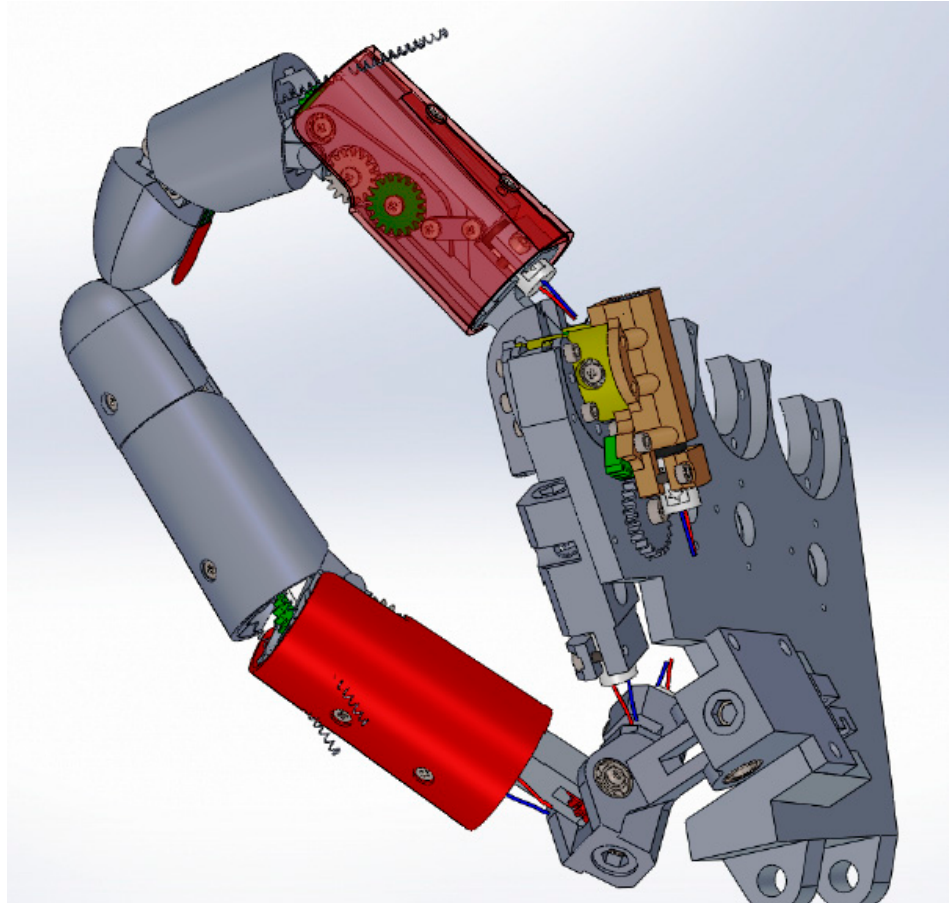
Figure 17. 3D model of the two fingers prototype, 2-FPRINT.